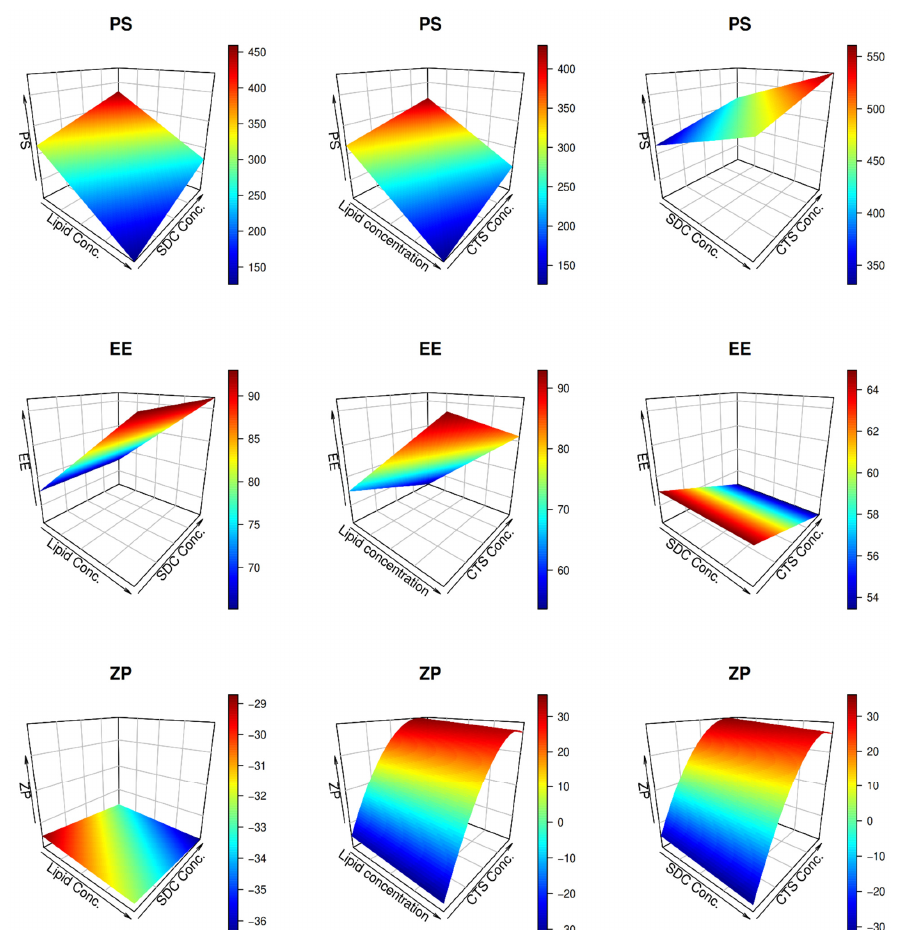
Figure 2. RSM plots for the impacts of the independent variables on the response variables concerning the optimization of